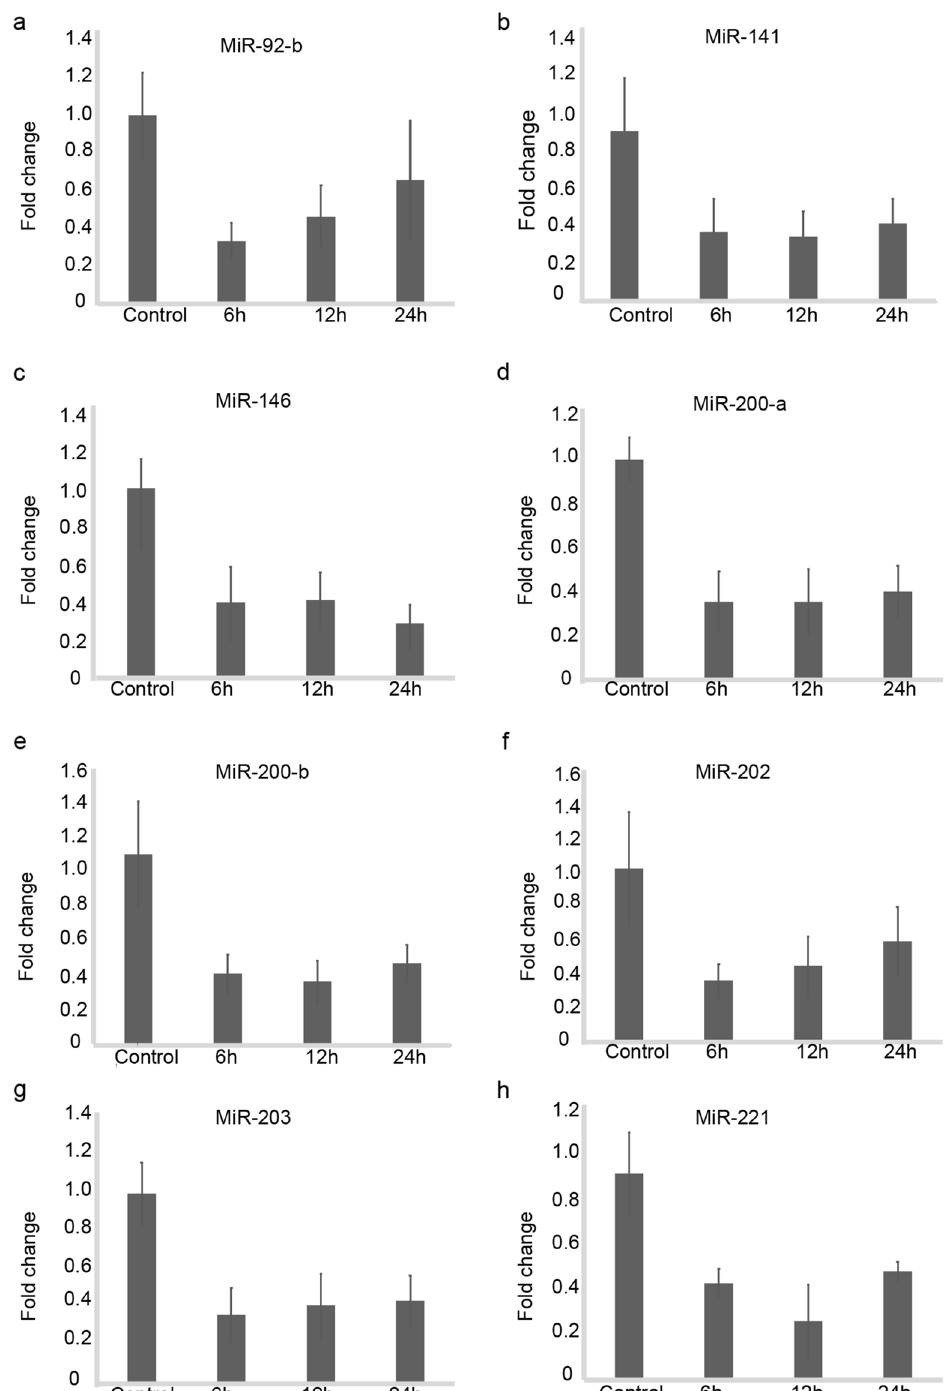
Figure 5. Validation of selected DE microRNAs in human primary urothelial cells upon in vitro wounding. Human primary urothelial cells were in vitro wounded, and the levels of 9 microRNAs were measured by RT-PCR at 6, 12 and 24 h post wounding. Bars represent average fold changes with their standard deviations in wounded urothelial cells at each timepoint and controls (non-wounded urothelial cells). ( a ) RT-PCR for miR-92-b ( b ) RT-PCR for miR-141 ( c ) RT-PCR for miR-146 ( d ) RT-PCR for miR-200-a ( e ) RT-PCR for miR- 200b ( f ) RT-PCR for miR-202 ( g ) RT-PCR for miR-203 ( h ) RT-PCR for miR-92-bRT-PCR for miR-202. One representative experiment is